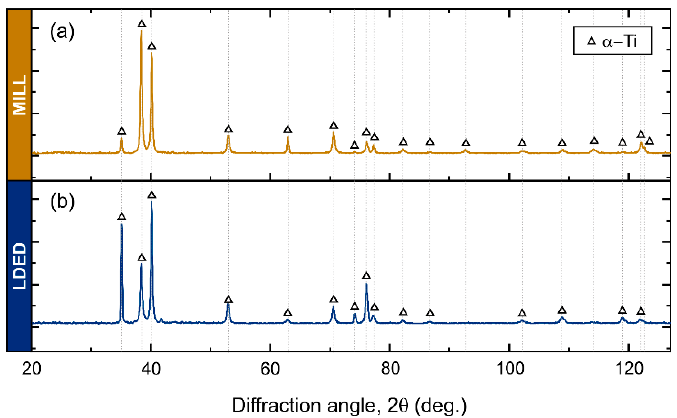
Figure 5. X-ray diffraction patterns of MILL ( a ) and LDED ( b ) materials.